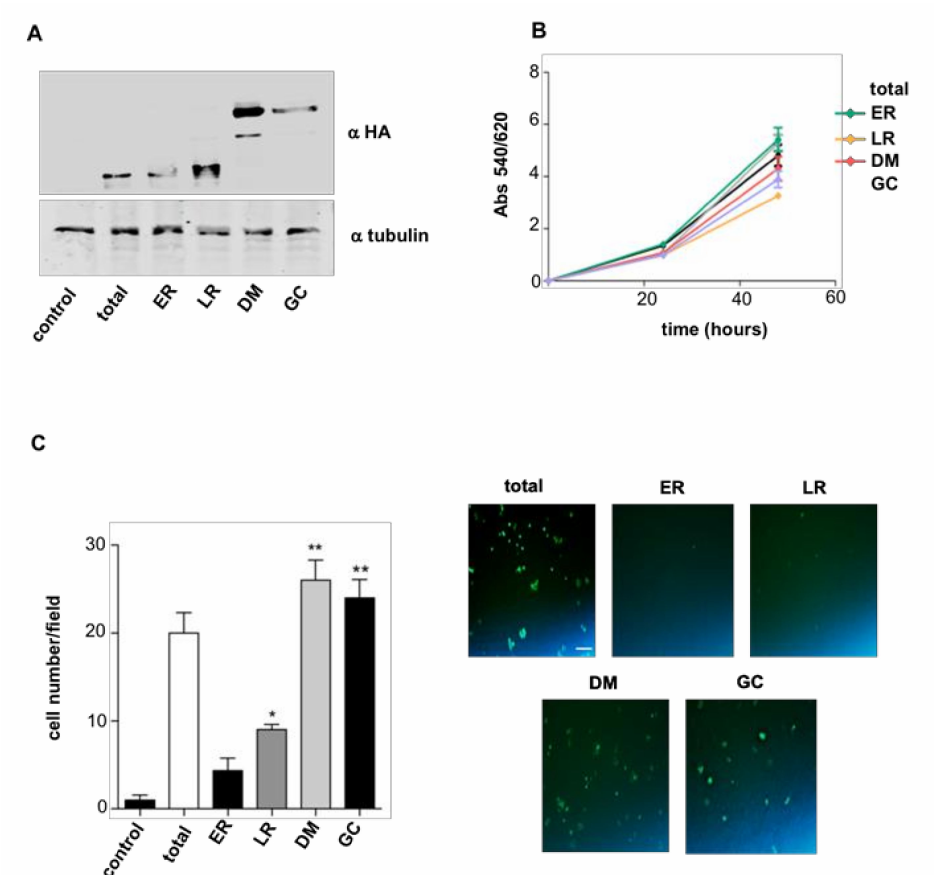
Figure 1. HRAS site-specific e ff ects on cellular proliferation and migration. ( A ) Expression levels of the targeted RAS proteins in stably transfected PCCL3 as determined by anti-HA immunoblotting. Cells were transfected with empty vector (control); HRAS V12 (total); M1-HRAS V12 (endoplasmic reticulum (ER)); LCK-HRAS V12 (LR); CD8-HRAS V12 (disordered membrane (DM)); and KDELr-HRAS V12 (Golgi complex (GC)). ( B ) Cellular proliferation rate of the aforementioned cell lines. ( C ) Transwell migration assay for the aforementioned cell lines. Left panel: data show mean ± SD of cells per field of three independent experiments. * p < 0.05, ** p < 0.01 by two- tailed unpaired Student t -test. Right panel: Caption of migrated cells through 8 µ m pore transwell after 24 h. Scale bar = 50 µ